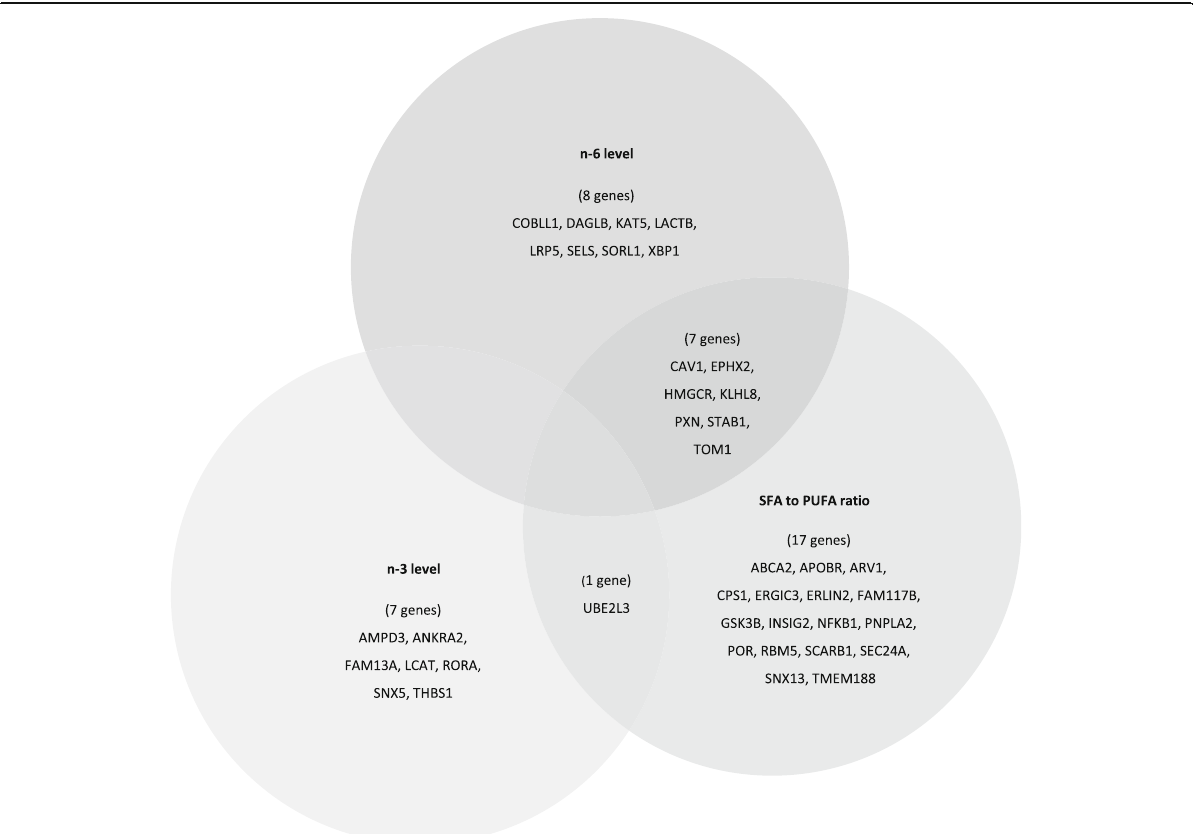
Fig. 2 Differently expressed genes associated with plasma fatty acid levels and SFA to PUA ratio. Number of differentially expressed genes associated with n-3 level (8 gene transcripts), n-6 level (15 gene transcripts), and SFA to PUFA ratio (25 gene transcripts). Seven differentially expressed genes were associated with both n-6 level and SFA to PUFA ratio, and one differently expressed gene was associated with both n-3 level and SFA to PUFA ratio. Differences in Log2 gene expression between subjects in the highest and lowest tertiles were compared by independent samples t test. P values < 0.05 were considered